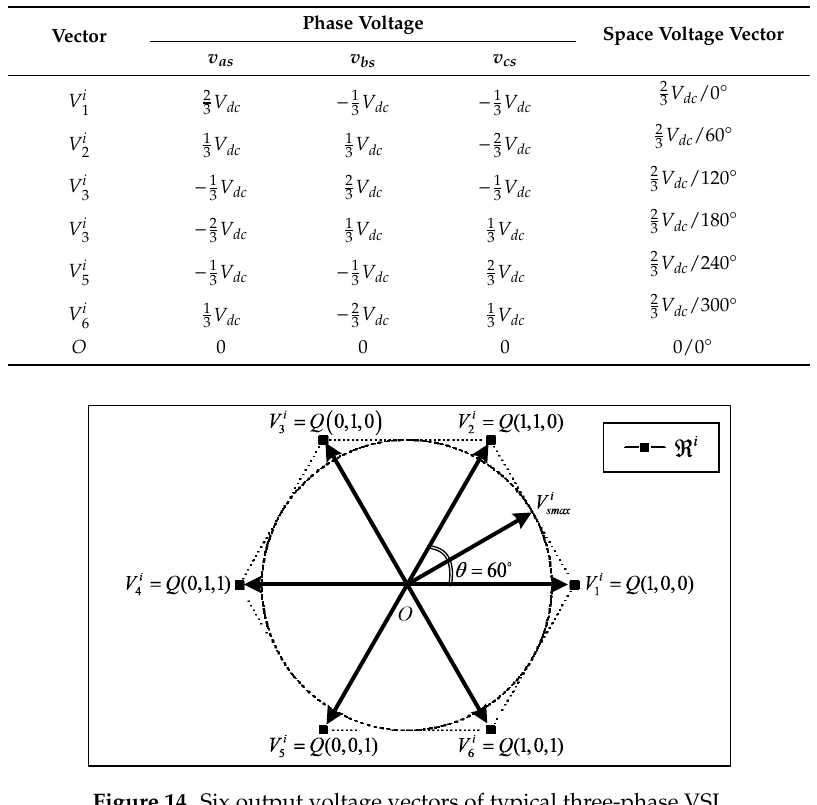
Figure 14. Six output voltage vectors of typical three-phase VSI. Table 1. The phase voltages and space voltage vectors of the typical three-phase VSI.